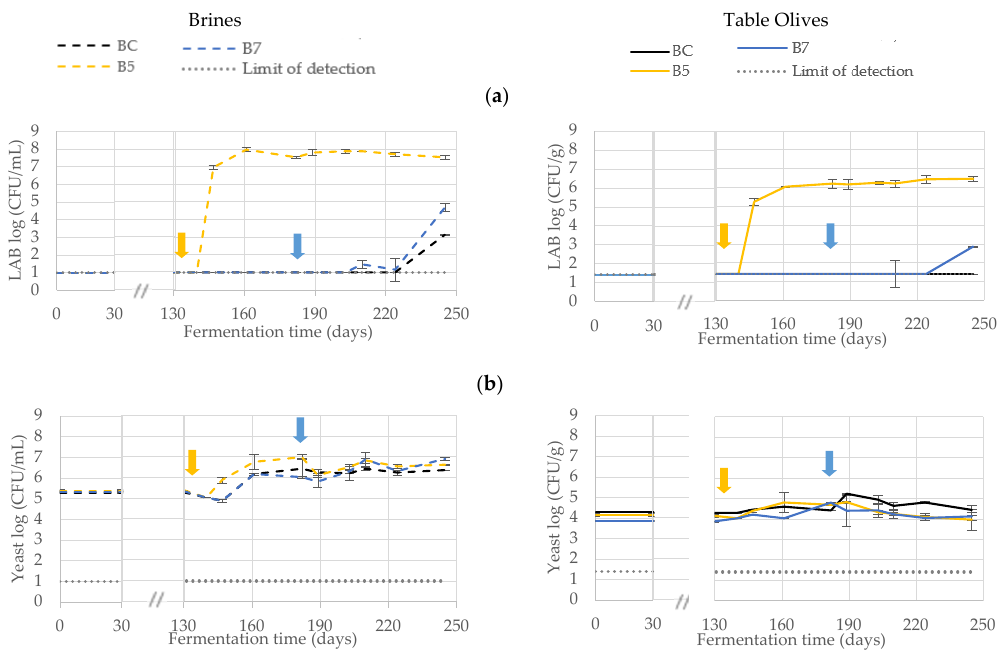
Figure 3. Evolution of viable numbers of ( a ) lactic acid bacteria and ( b ) yeasts, in ( left ) brines and ( right ) table olives, under plan B. Arrows indicate the moment of inoculation with Lpb. pentosus i106 and the corresponding salt addition to all vessels.